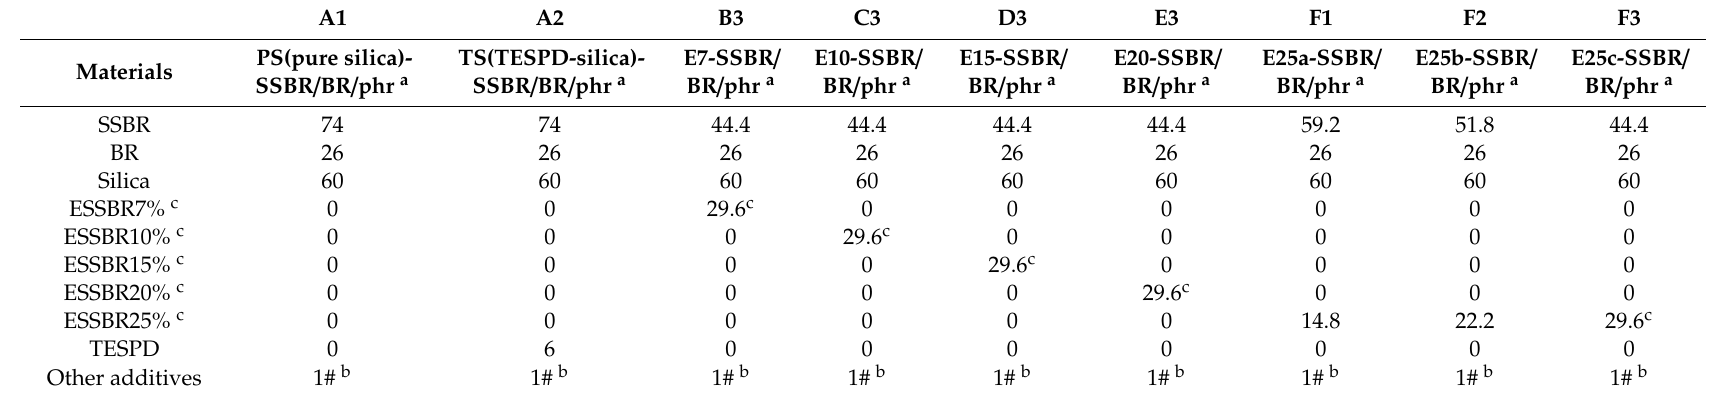
Table 1. Formulation of silica / solution polymerized styrene-butadiene rubber (SSBR) / butadiene rubber (BR)